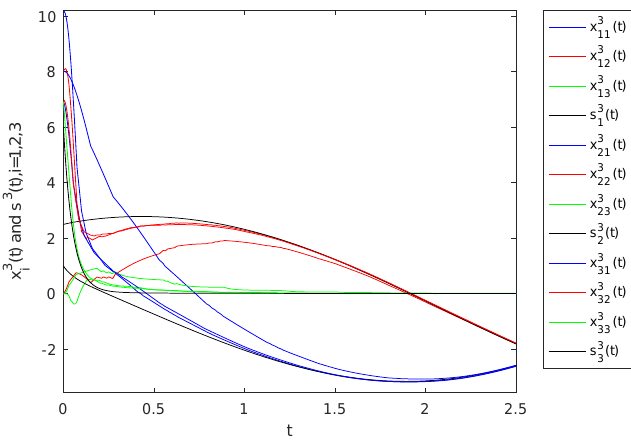
( 3 ) ( t ) and s ( 3 ) ( t ) under Controller ı